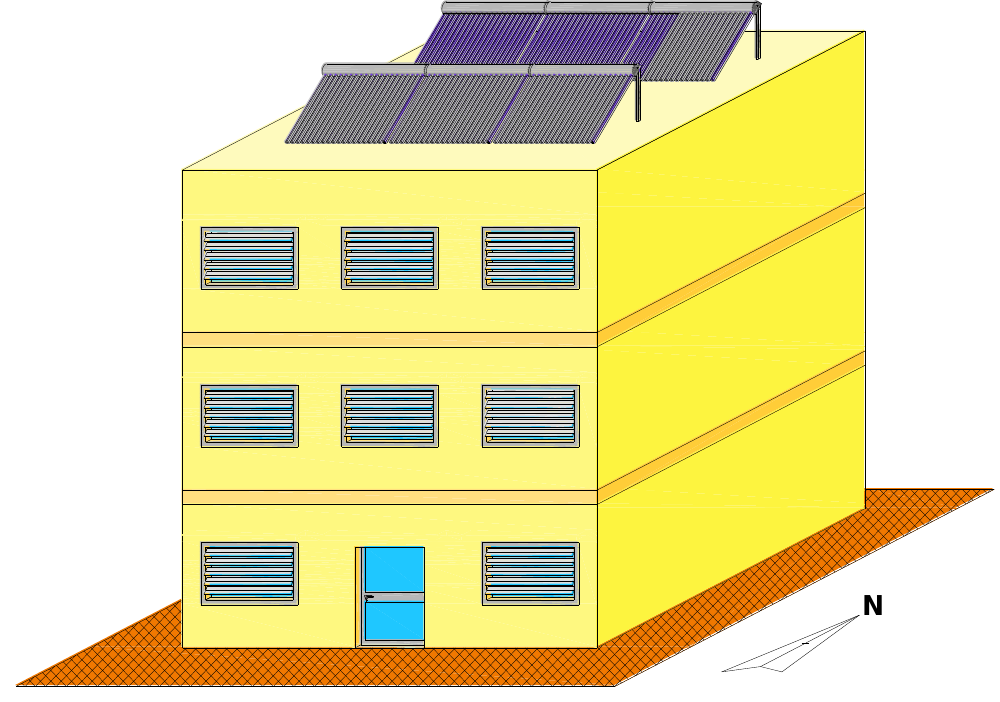
Figure 1. Three-story office building. Table 1. Main characteristics of building envelope.